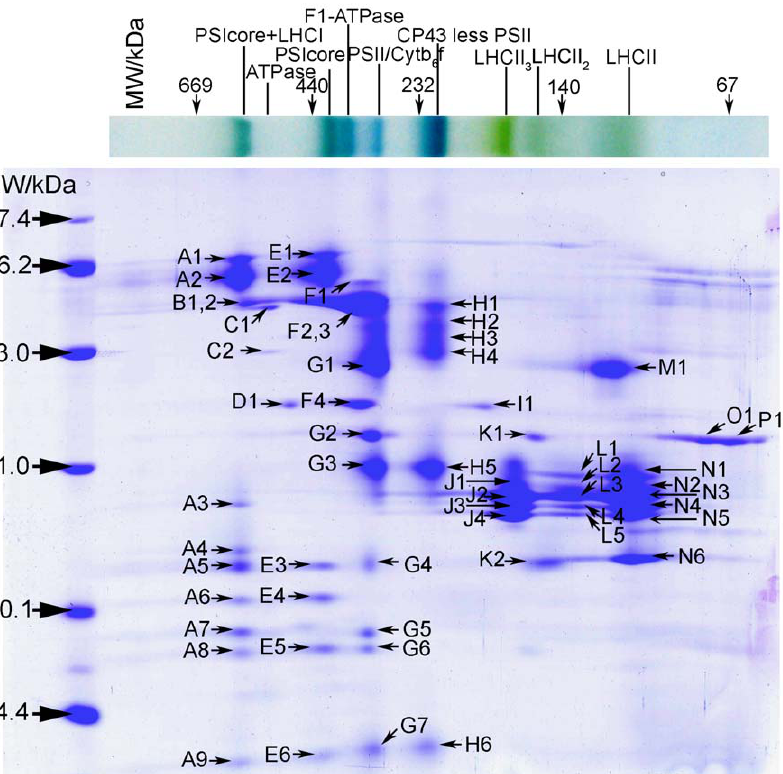
Figure 4. The constituent subunit pattern of thylakoid membrane complexes in rice ( Oryzasativa L.) resolved using ‘‘Double-Strips BN/SDS-PAGE’’ (Each protein spot was marked with capital letter plus Roman numeral, which was corresponded to the spot mark in Table 2.)